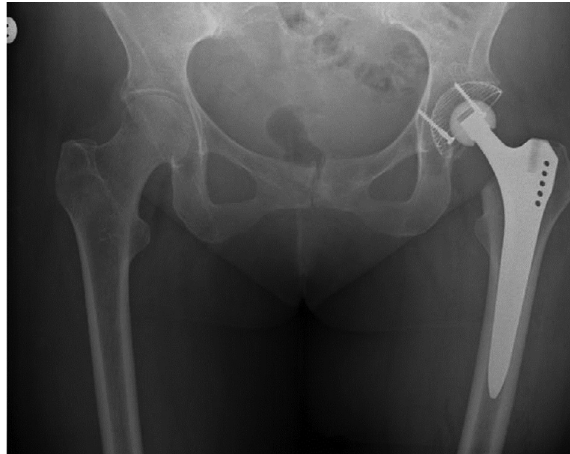
Figure 2. Left total hip